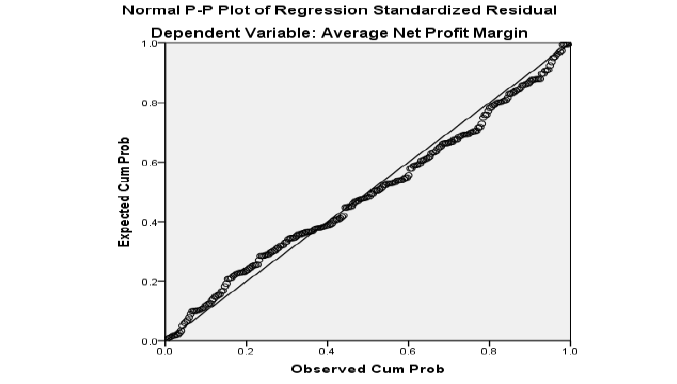
Figure 1: Normal P-P Plot for Normality Testing; Source: Study Data